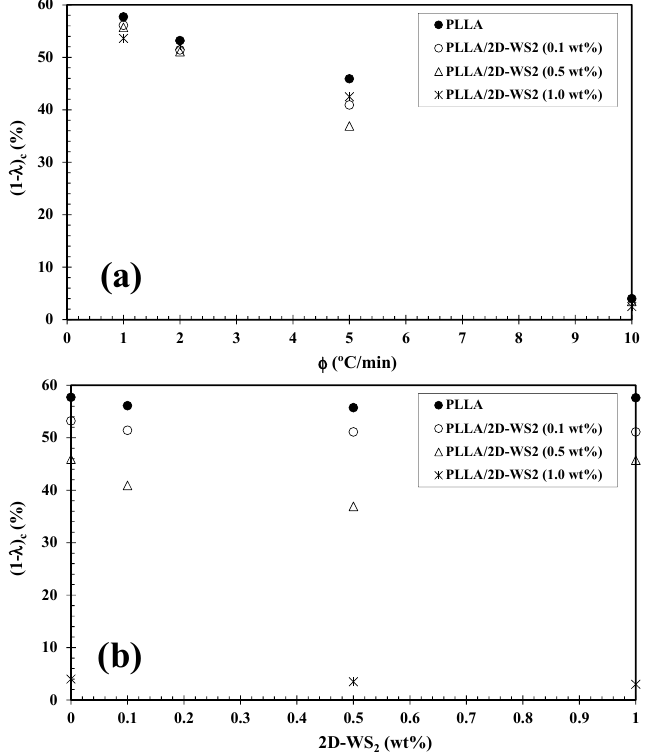
Figure 5. Variation of the crystallinity (1- α ) c for PLLA/2D-WS 2 nanocomposites with ( a ) cooling rate and ( b ) composition.